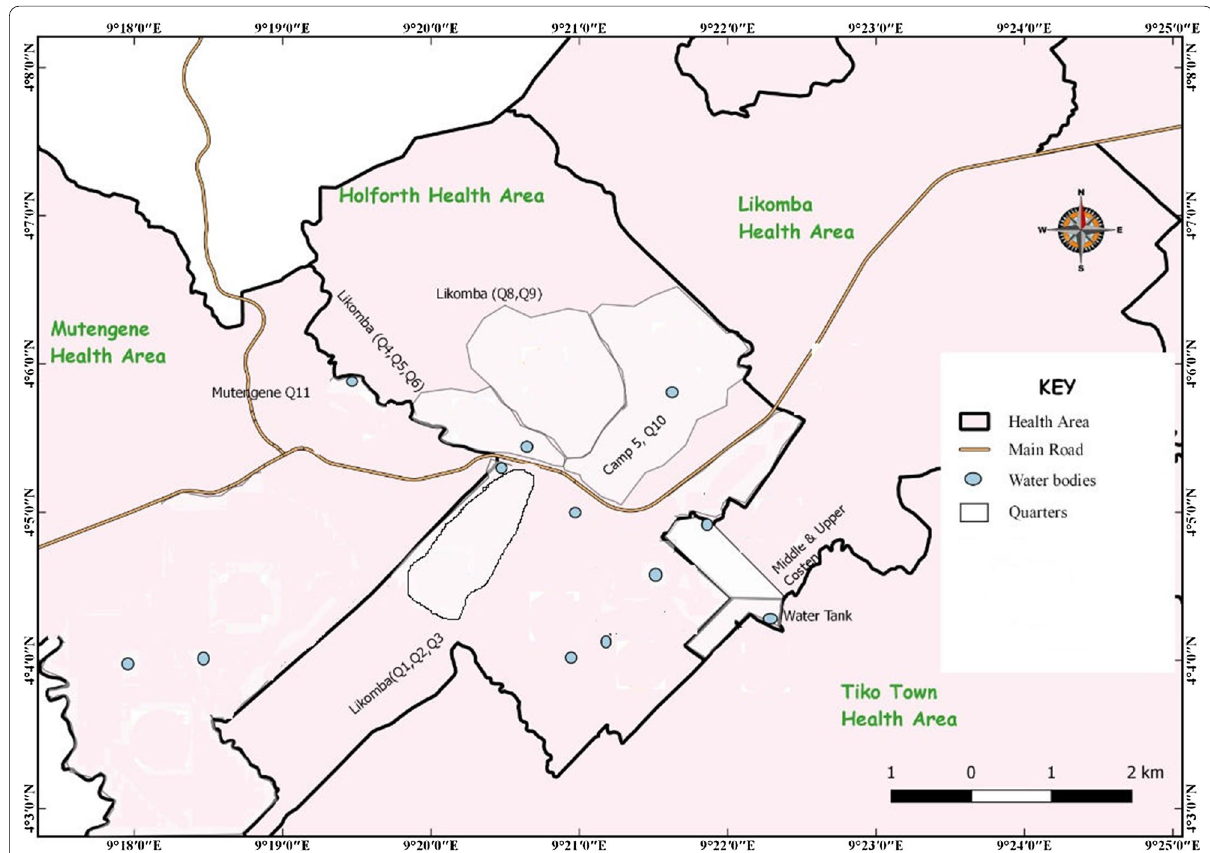
Fig. 1 Map showing the study sites (Likomba and Upper Costen) and water